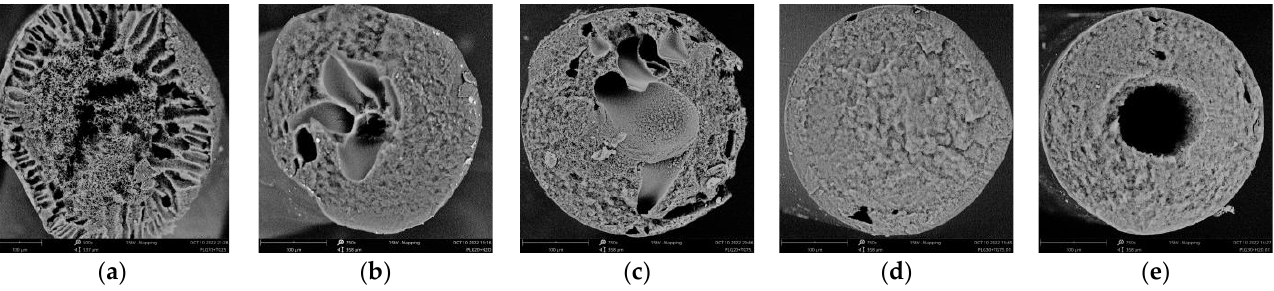
Figure 8. Internal structure of fibers formed from PLGA/TG mixtures via immersion into water and a TG/water mixture. PLGA concentration: ( a ) 10 wt.%, ( b , c ) 20 wt.%, ( d , e ) 30 wt.%. Nonsolvent: ( a , c , e ) water and ( b , d ) 75% aqueous TG solution.